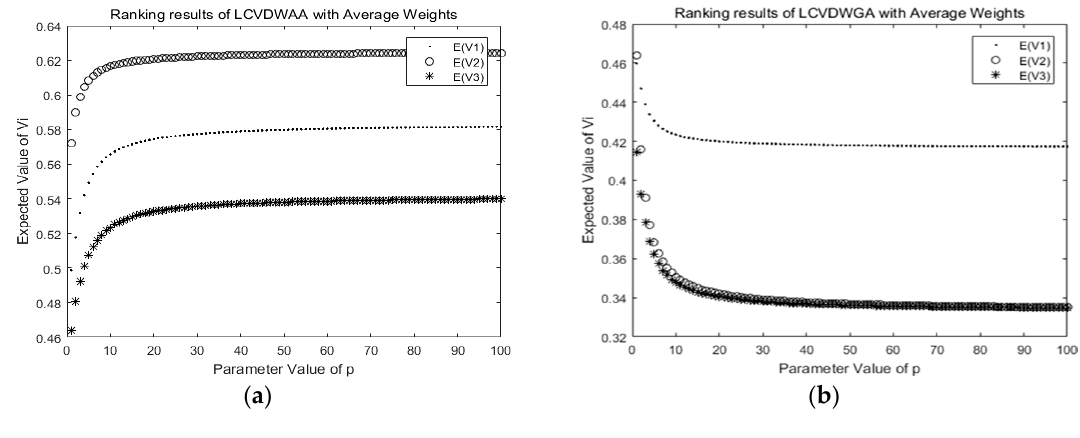
Figure 2. Ranking results with average weights in Example 3. ( a ) LCVDWAA operator; ( b ) LCVDWGA operator.